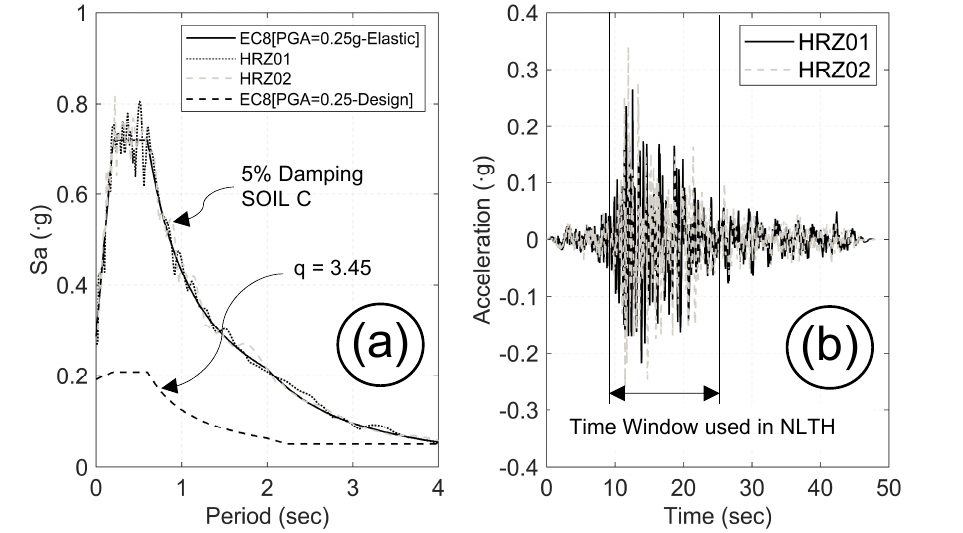
Figure 11. Seismic demand: ( a ) Response spectrum; ( b ) Herceg–Novi (1979) acceleration time